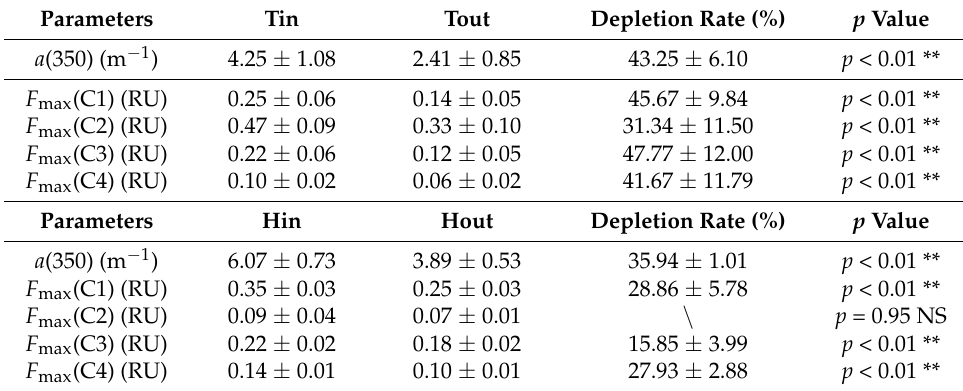
Table 4. Differences in mean values of a (350) and F max of four fluorescent components between upstream and downstream and the corresponding depletion rates in littoral zones of Lakes Taihu and